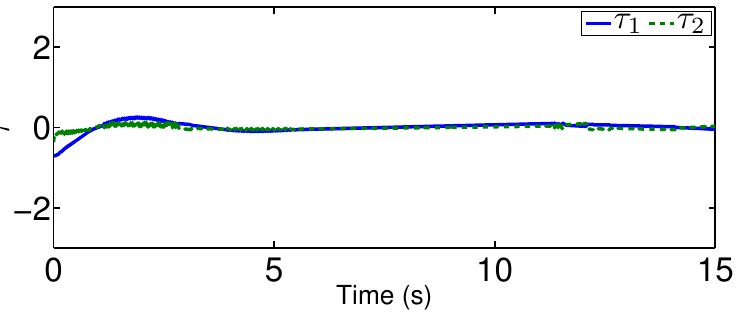
Figure 10. Control trajectory τ under the existing controller.